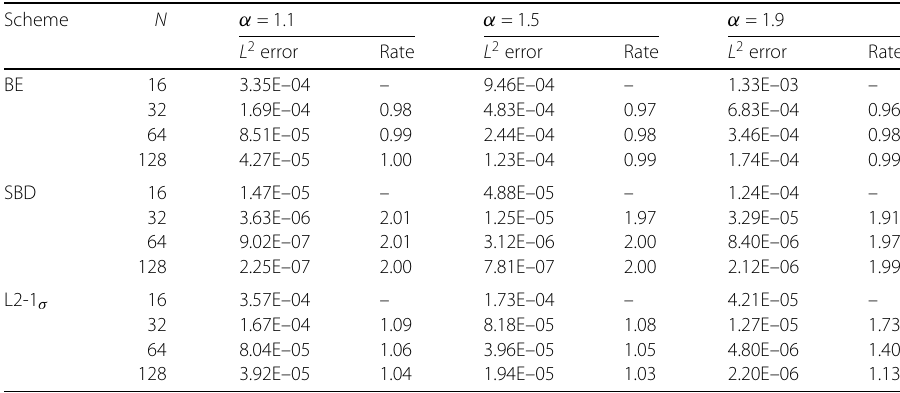
Table 6 The L 2 norm errors in time for case (d) in Example 6.2 with h =